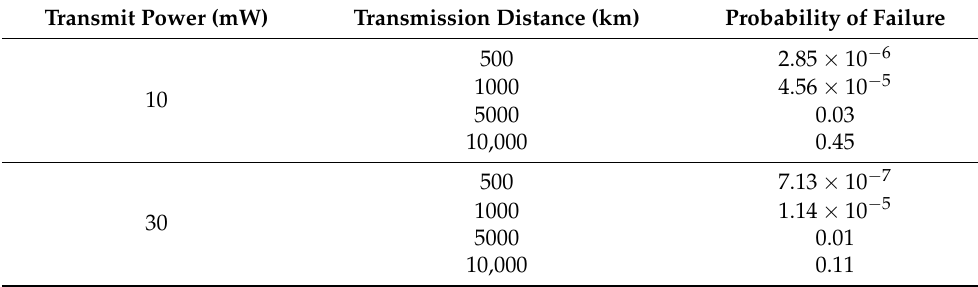
Table 1. Failure probability with different transmission distances and power.